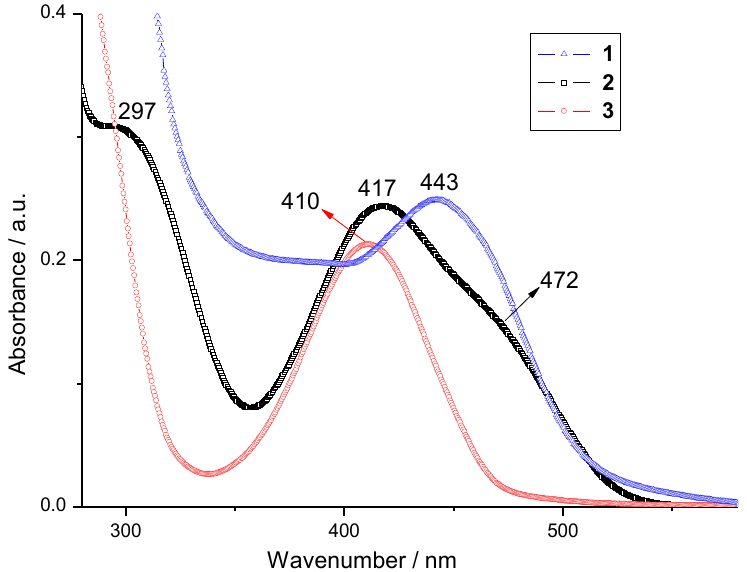
Figure 1. UV–vis absorption spectra of the Mn III complexes 1 , 2 , and 3 in DMF solution (c = 1 × 10 −5 mol/L).